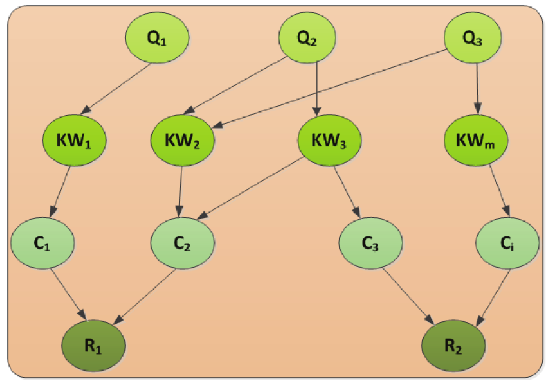
Fig. 5. Semantic Bayesian